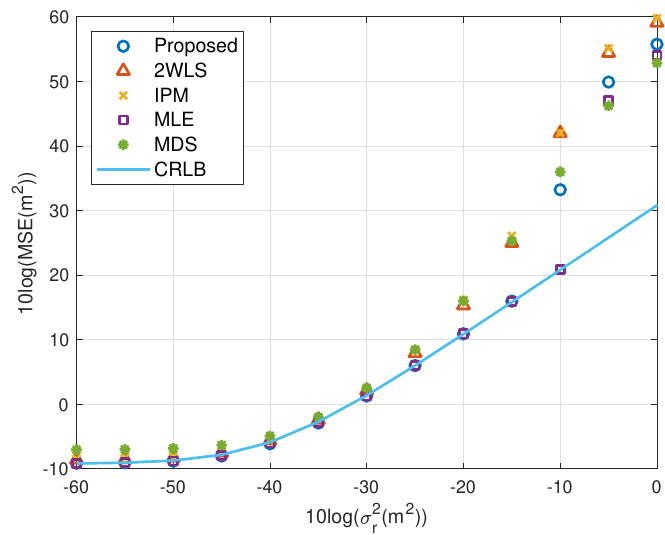
Figure 4. MSE performance as noise power increasing (far source, 4 sensors).